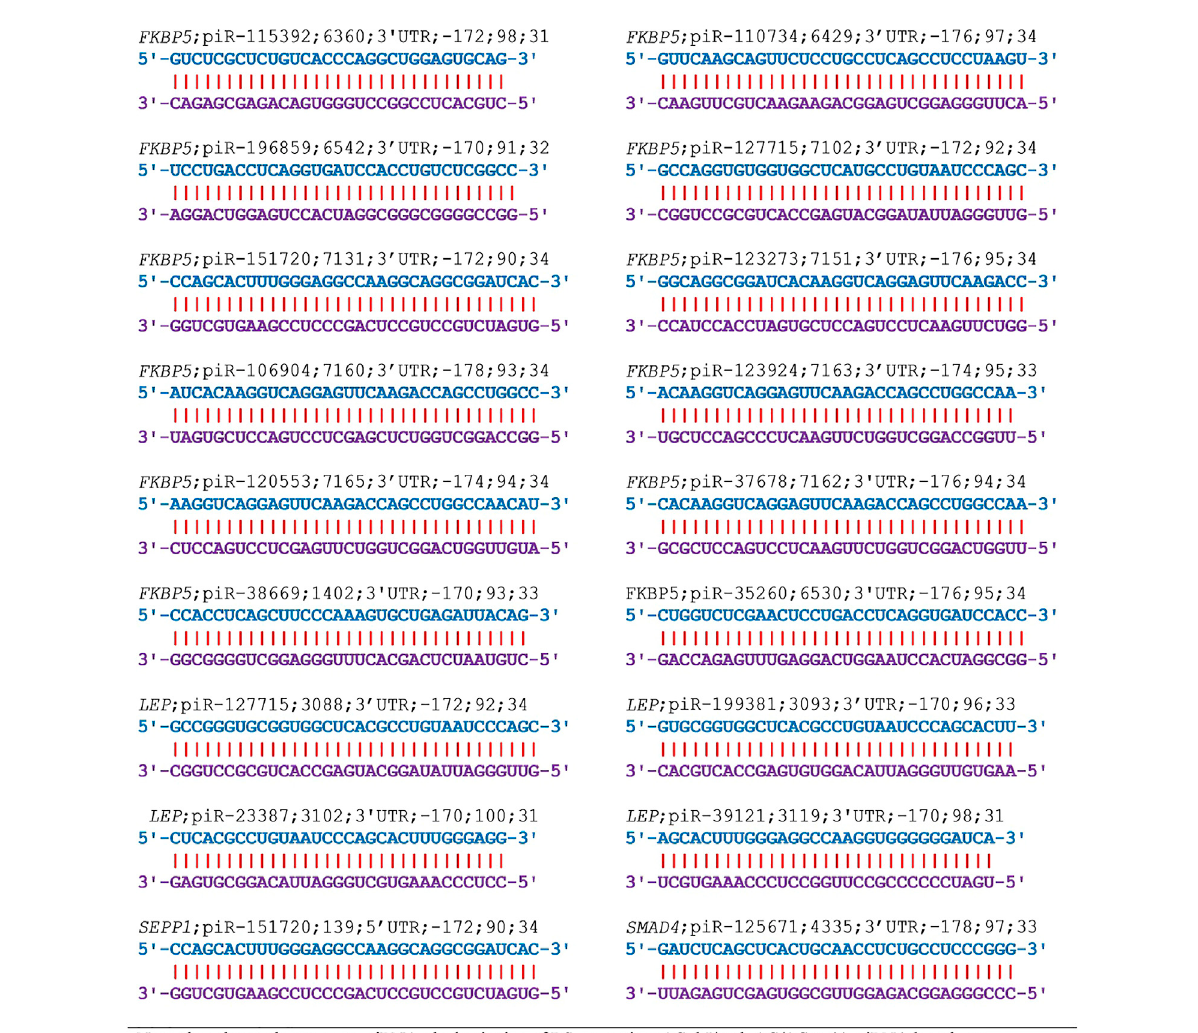
FIGURE 1 The schemes of interaction between piRNAs and mRNAs of EAC candidate genes with Δ G values of − 170 kJ/mol and